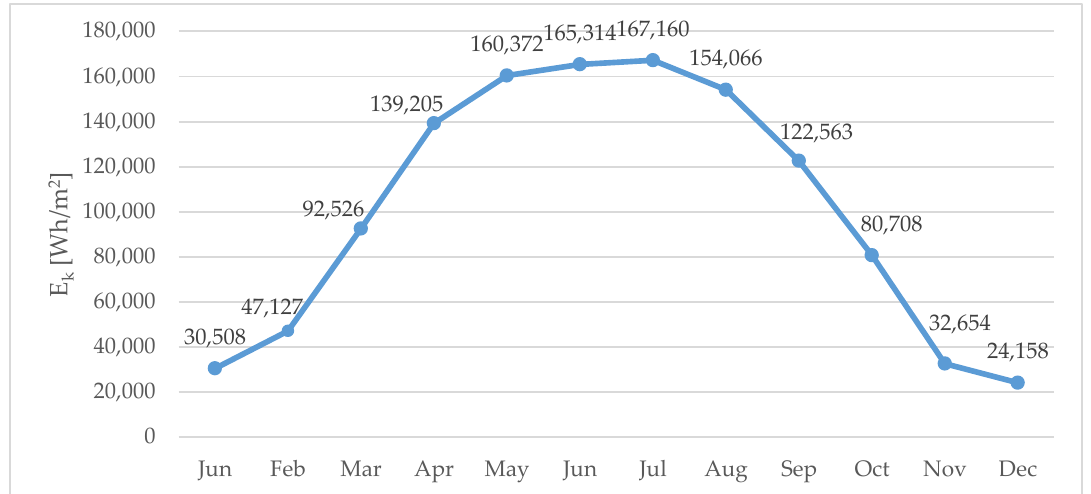
Figure 8. Graph of average irradiance values during the year in the building location for an optimized slope angle 38°.